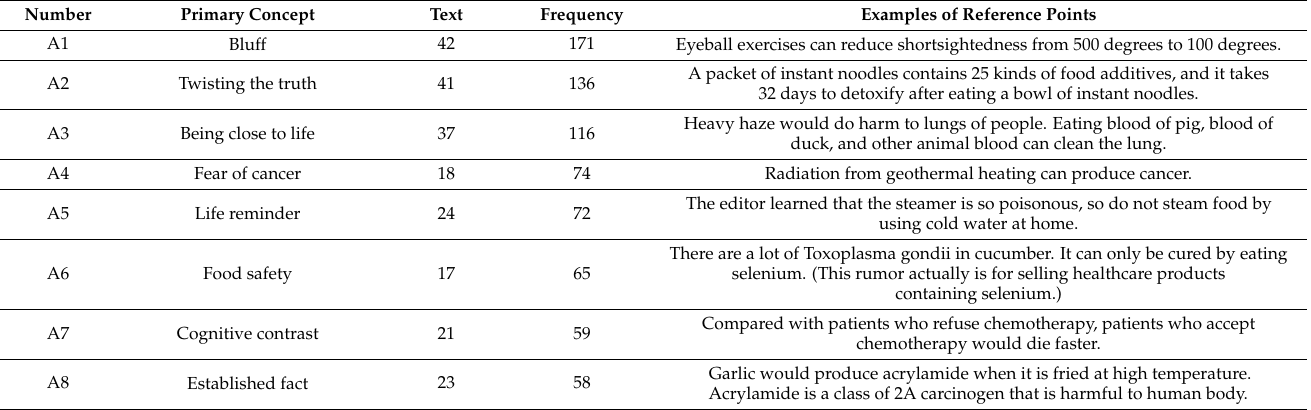
Table 1. The results of open